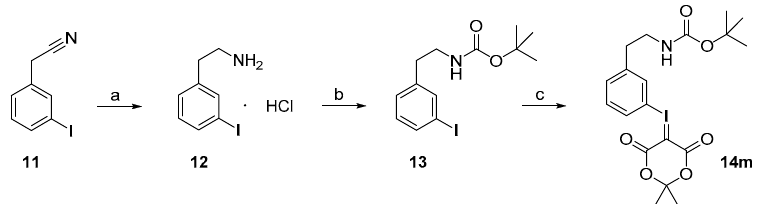
Scheme 3. Synthesis of the iodonium ylide precursor 14m . Reagents and conditions : (a) 1. BH 3 ∙ THF,